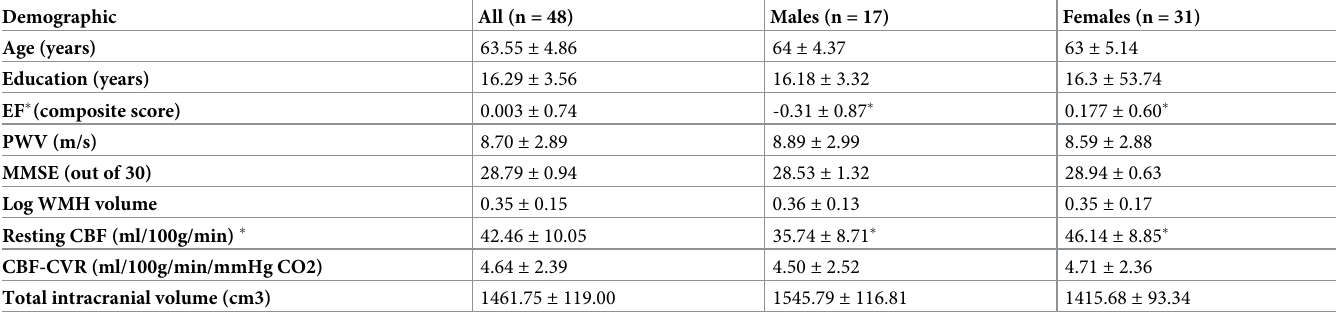
Table 1. Participant